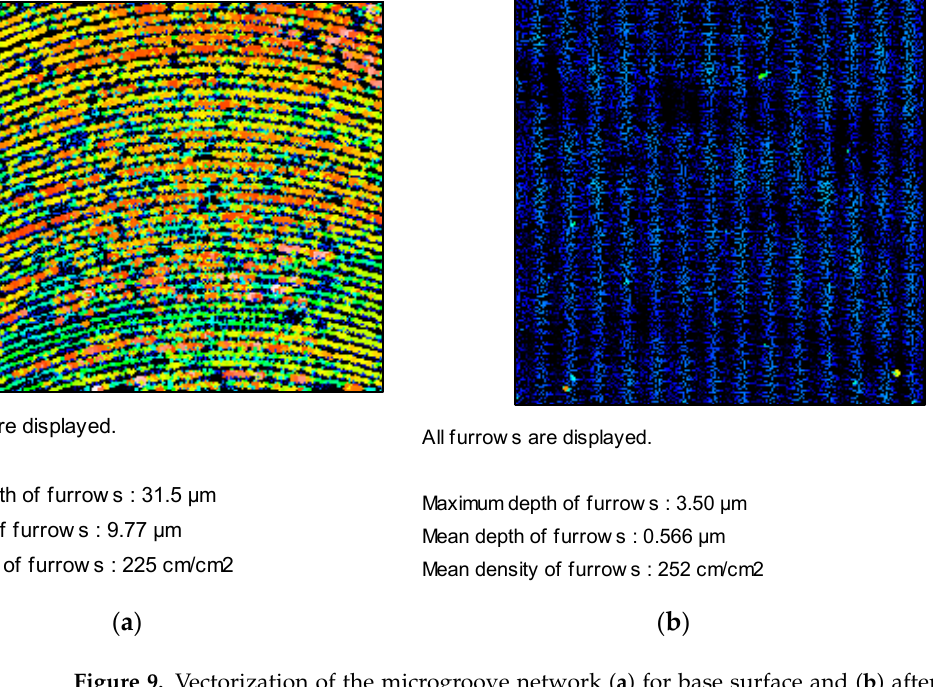
Figure 9. Vectorization of the microgroove network ( a ) for base surface and ( b ) after burnishing 𝑃 = 60 N , 𝑓 = 1500 mm/min (experimental run no. 9).